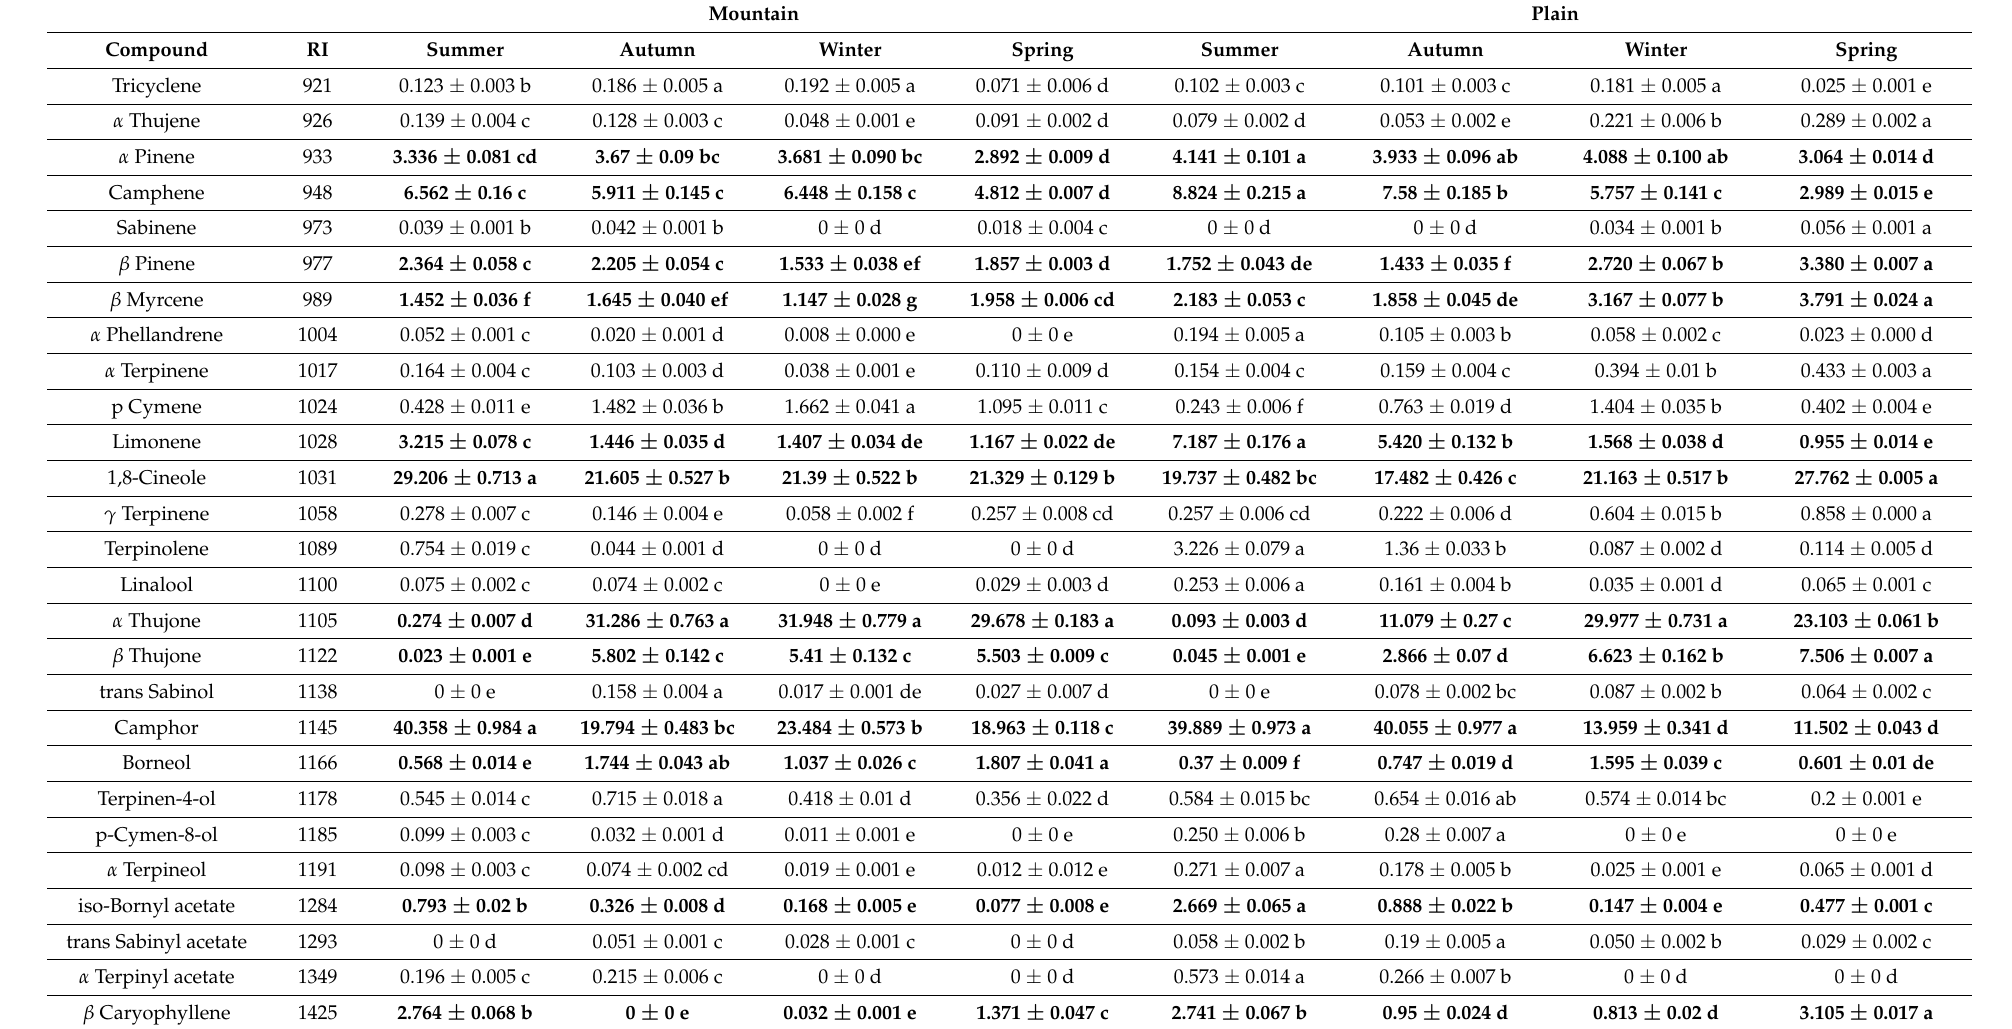
Table 5. Chemical composition (%) of essential oils of sage